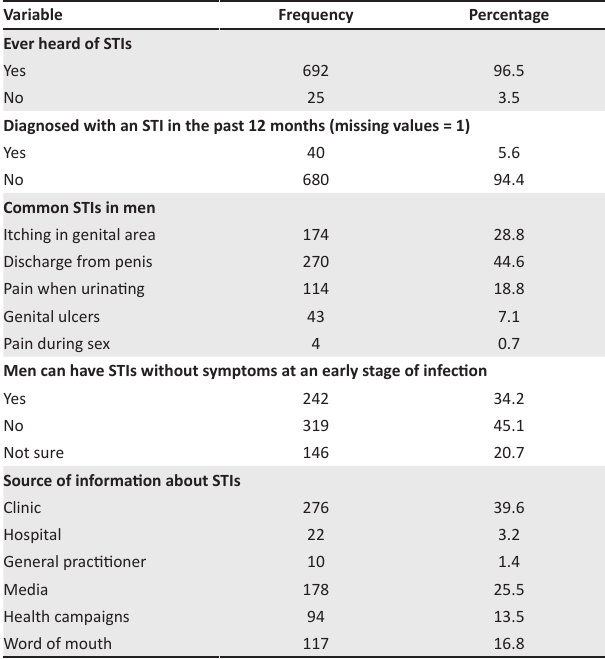
TABLE 2: Awareness and knowledge of sexually transmitted infection symptoms and source of sexually transmitted infection